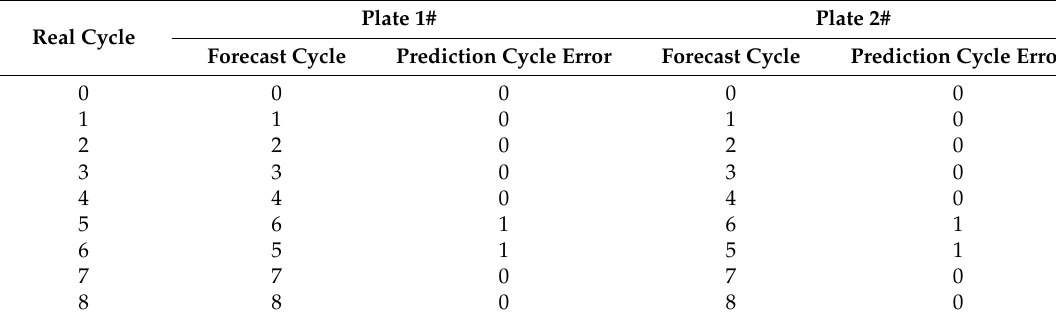
Table 3. Prediction results of neural network